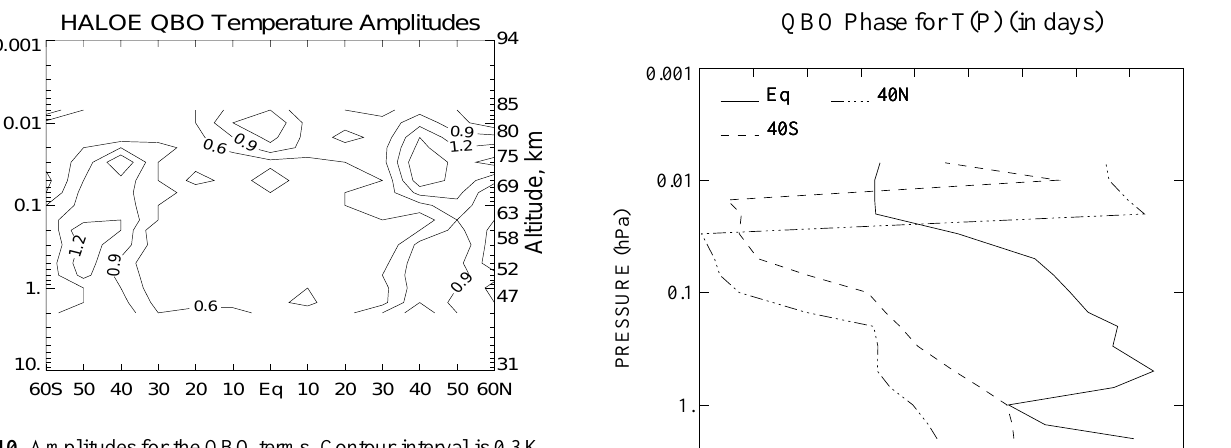
Fig. 10. Amplitudes for the QBO terms. Contour interval is 0.3K.